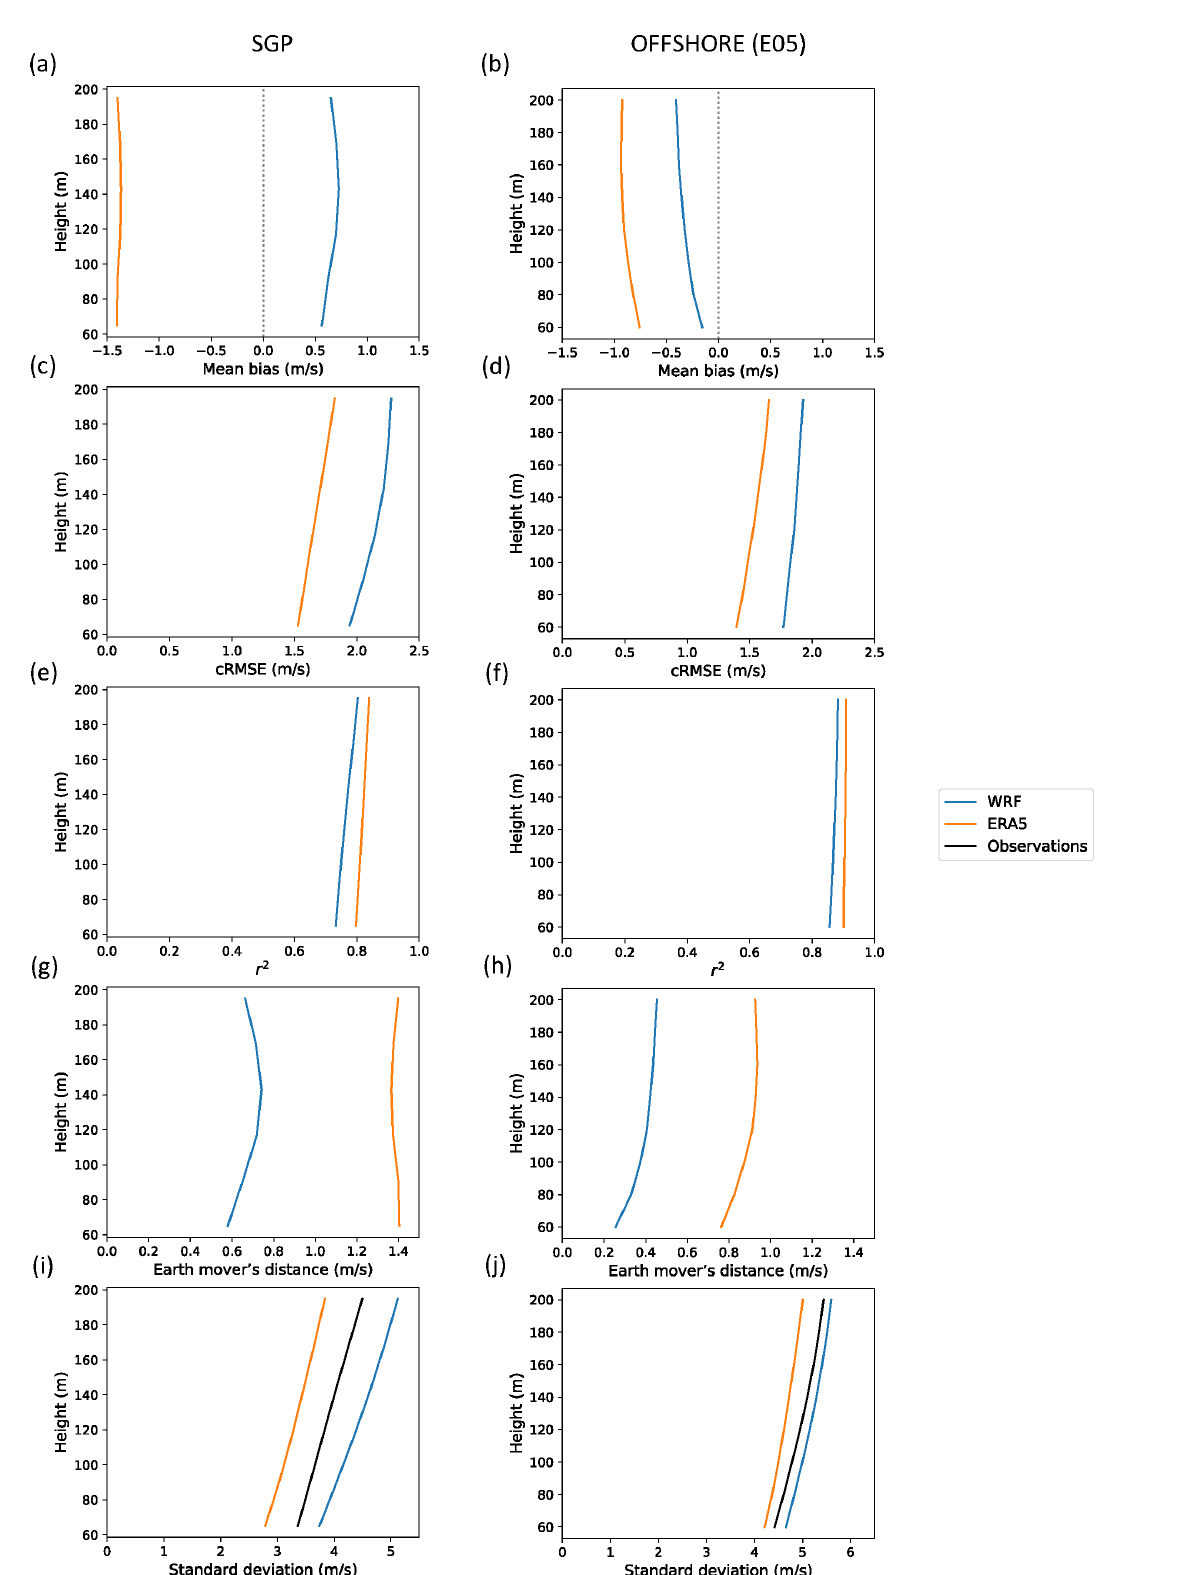
Figure 5. Vertical profiles of mean bias, cRMSE, r 2 , EMD, and wind speed standard deviation at the SGP C1 site (left) and the E05 lidar (right). Results from the E06 lidar are included in the